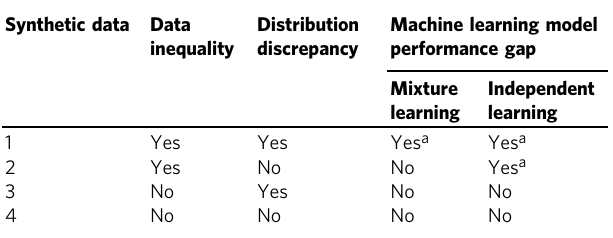
Table 2 Multiethnic machine learning experiments on synthetic data.